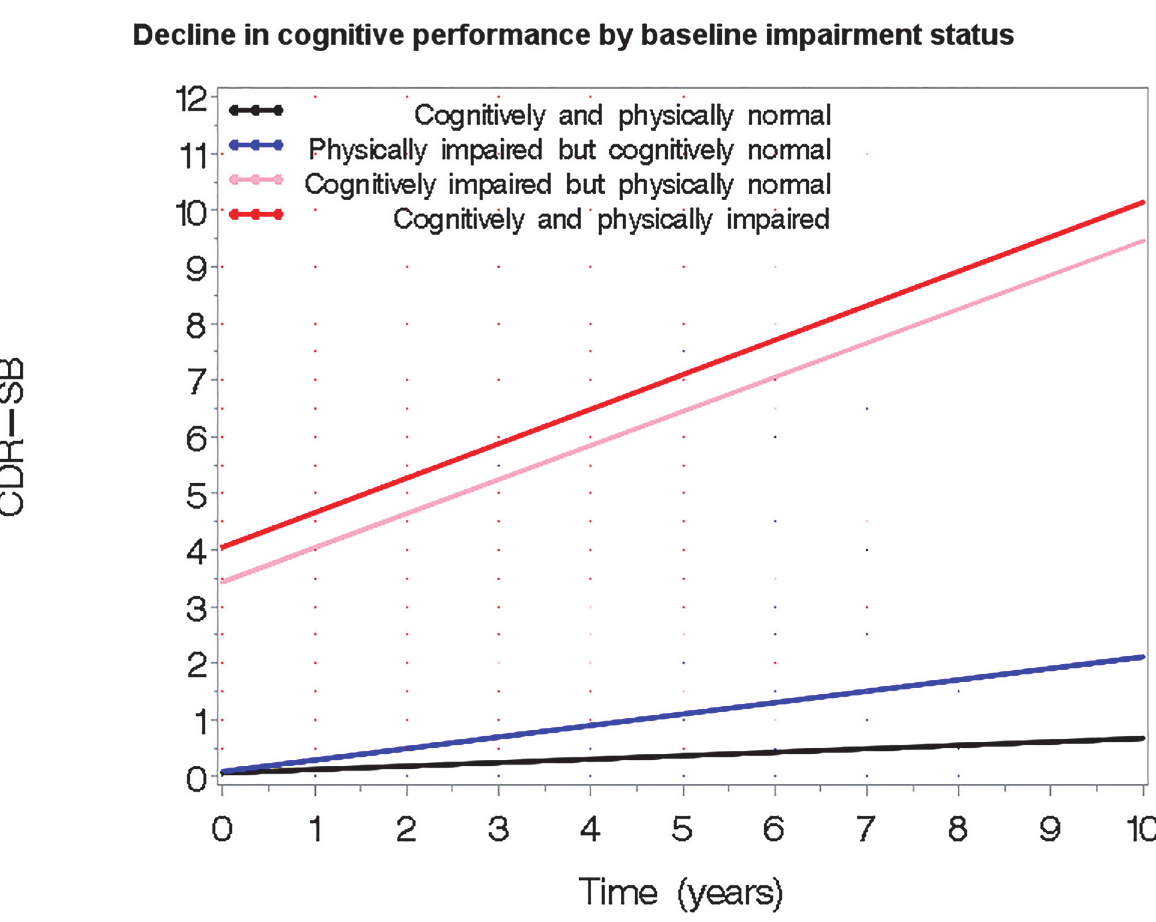
Fig 2. Decline in cognitive function by baseline cognitive/physical impairment status. Significantly steeper decline in global cognitive performance (measured with CDR-SB score) was noted in the CI and CPI groups, although physical impairment does not add much above what is seen in the CI group. In contrast, the PI group appears to decline in physical functionality at similar rates with the NI. Results are from the full model adjusted for age, gender, education, race and baseline physical